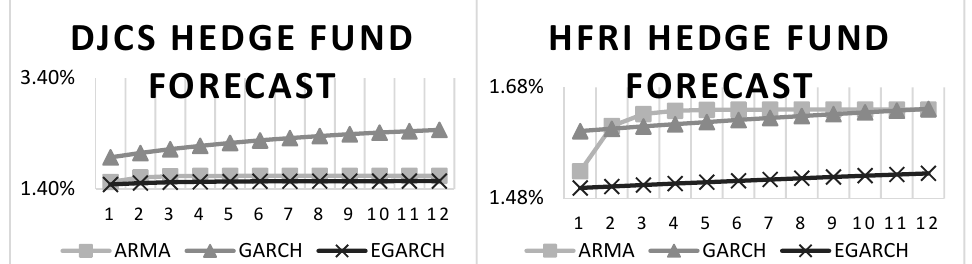
Figure 17. Hedge fund model forecasts (12 months). Source: authors.